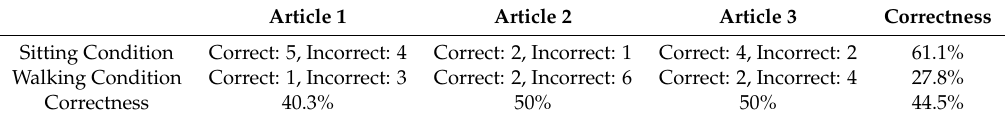
Table 7. Results of the questions after reading task as an approximation of reading quality.